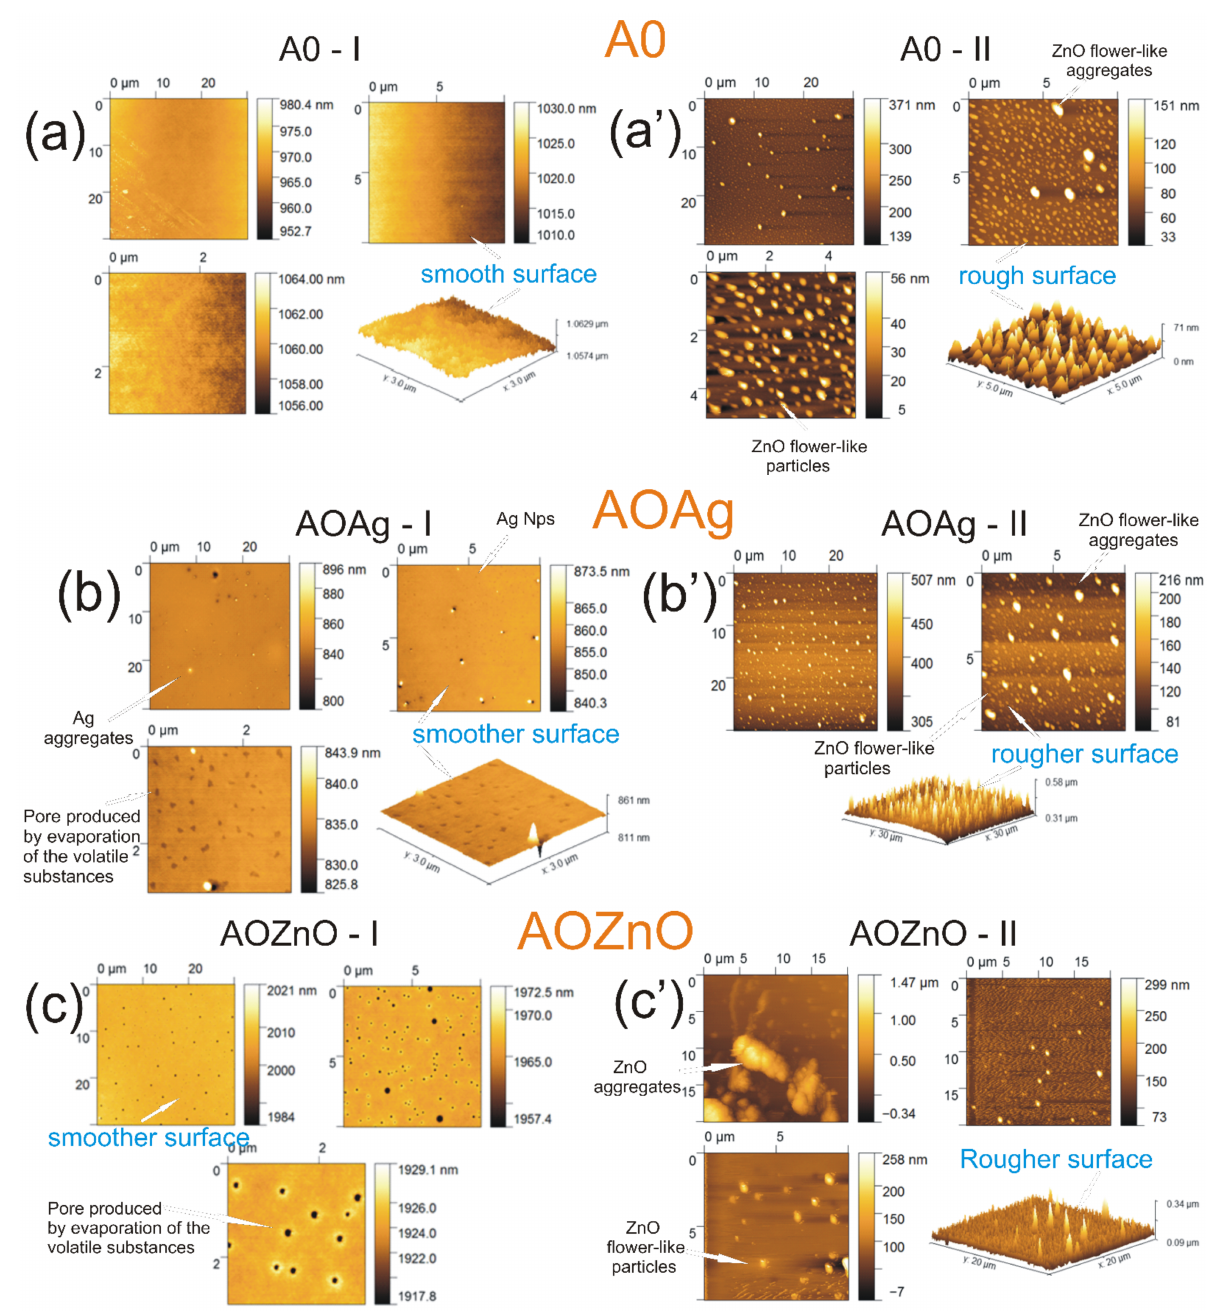
Figure 2. AFM images of the mono- and bilayer coatings deposited on glass slides: ( a ) A0-I; ( a’ ) A0-II; ( b ) AOAg-I; ( b’ ) AOAg-II; ( c ) AOZnO-I; ( c’ )